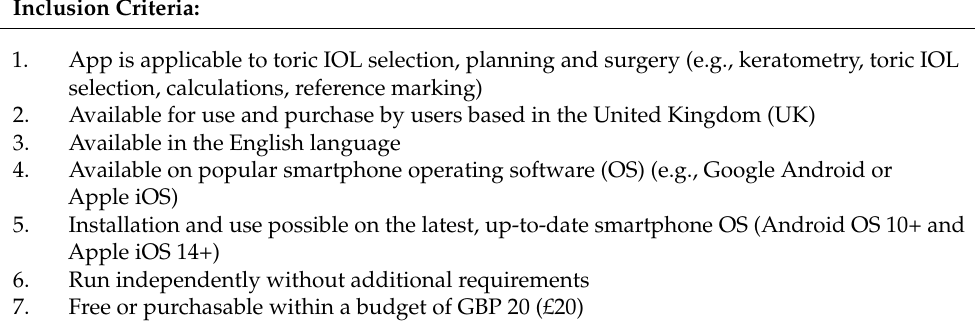
Table 1. Inclusion and exclusion criteria for our systematic app search strategy.